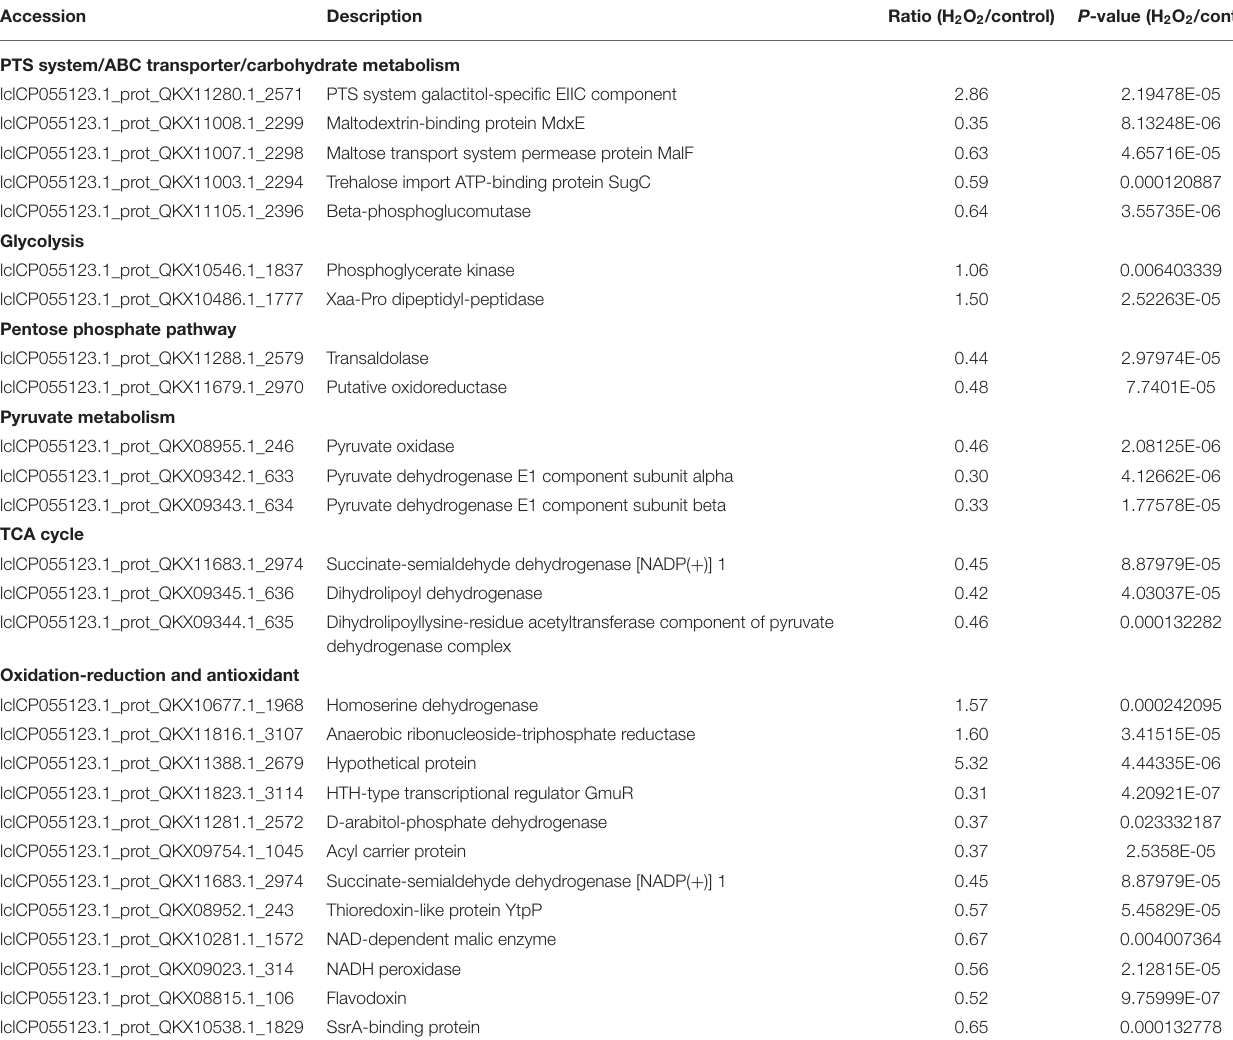
TABLE 2 | Differentially expressed proteins (DEPs) of L. plantarum KM1 under H 2 O 2